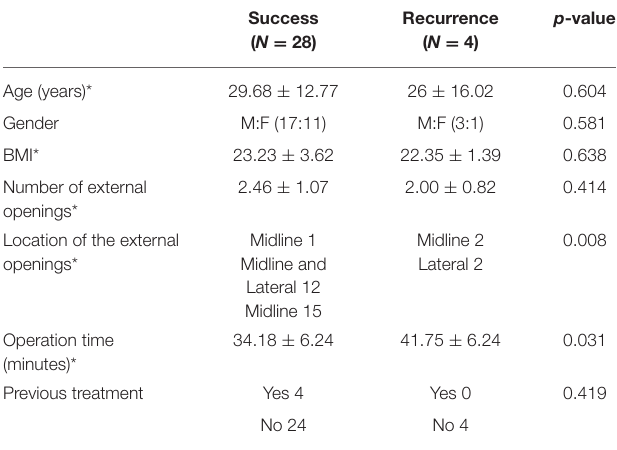
TABLE 4 | Comparison of results in both groups.